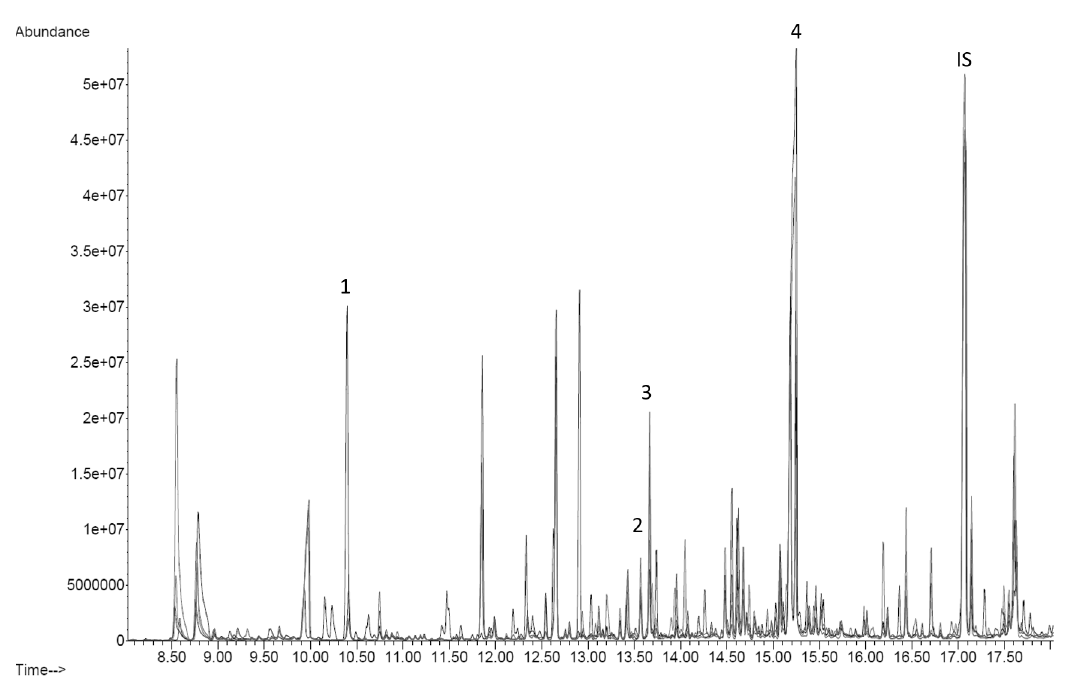
Figure 4 The typical total ion chromatogram of derivatized organic acids in the urine of autistic children. 1- benzoic acid; 2- p -hydroxybenzoic acid; 3- p -hydroxyphenylacetic acid; 4- hippuric acid; IS- internal standard (heptadecanoic